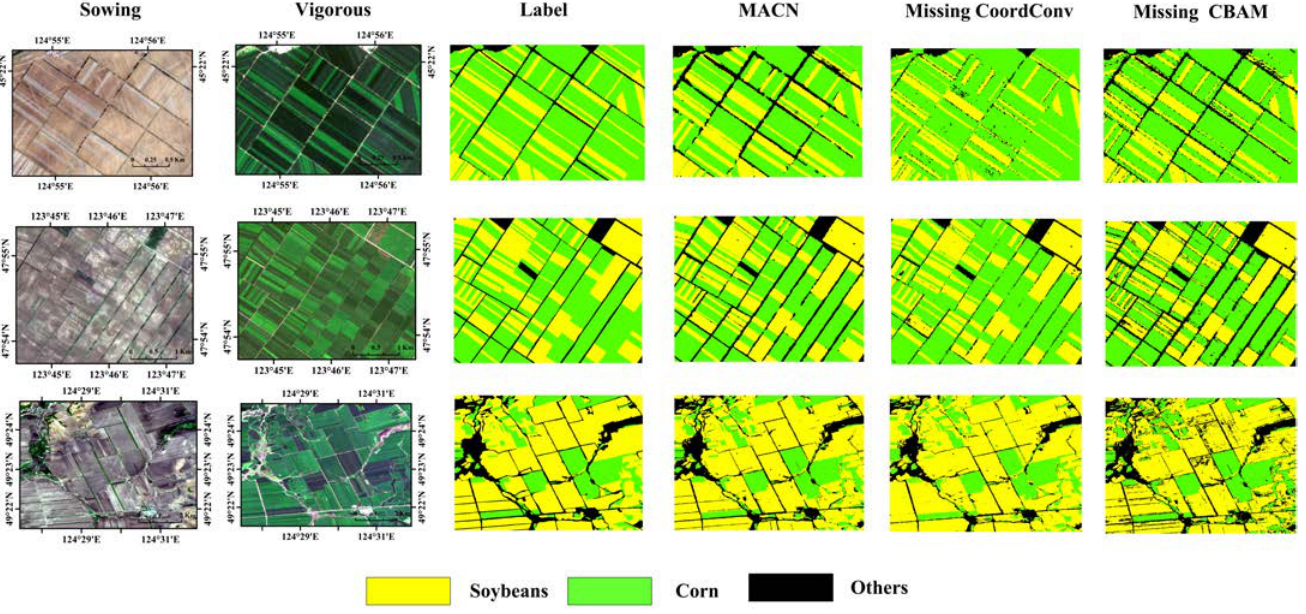
Figure 15. The classification results of MACN, Missing CoordConv and Missing CBAM. Table 5. Accuracy of crop classification for MACN, Missing CoordConv and Missing CBAM.